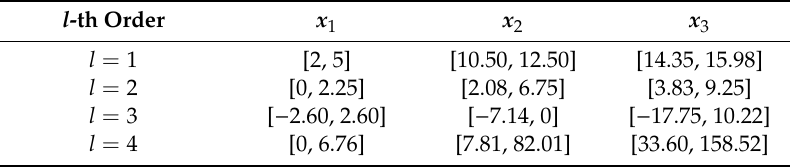
Table 3. Four statistical moments of epistemic uncertainties in example